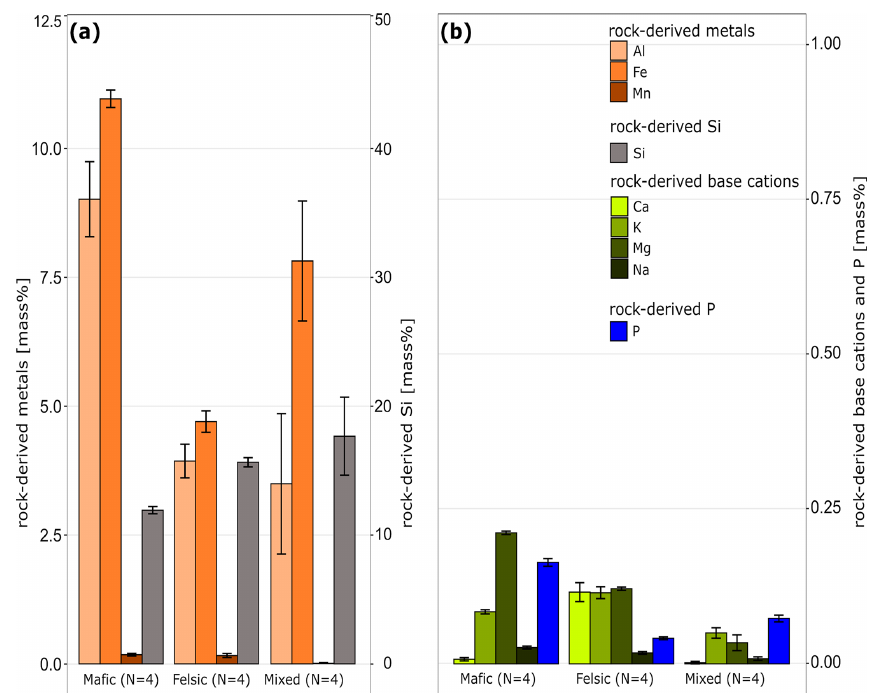
Figure 4. Soil chemical composition of subsoil in stable, old-growth closed-canopy forests (no erosion) in the three investigated geochemical regions (mean ± standard error). The data illustrate the convergence of elemental concentrations between the three regions as a result of weathering and soil development. Abbreviations explained in Fig. 3. Note the difference in scale on the y axis between panels (a) and (b) .